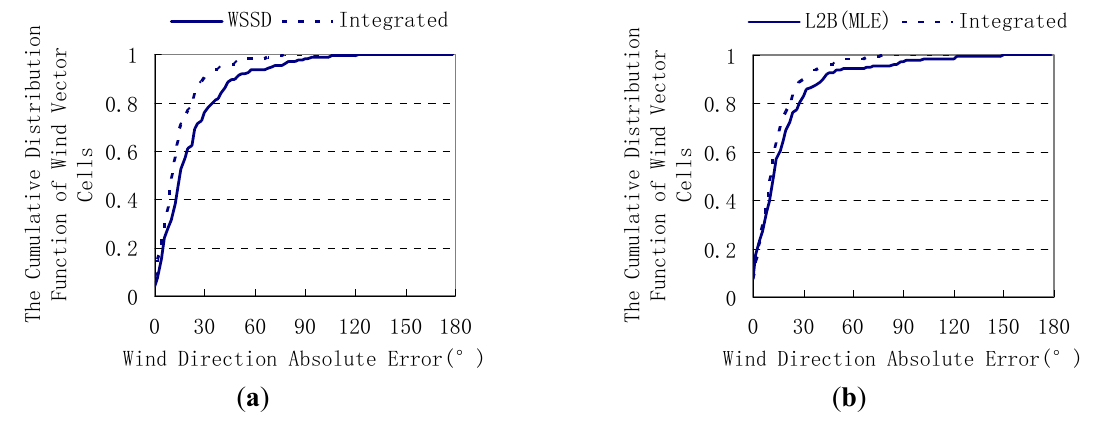
Figure 2. Cumulative distribution function of wind vector cells at each directional absolute error in the nadir region: ( a ) comparisons between the traditional wind speed standard deviation (WSSD) and the integrated algorithm and ( b ) comparisons between the integrated algorithm and the L2B (MLE)